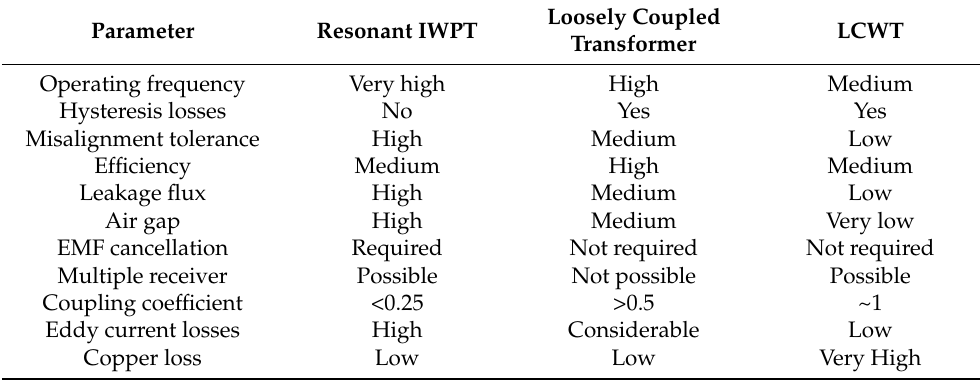
Table 2. Comparison of various IWPT systems.